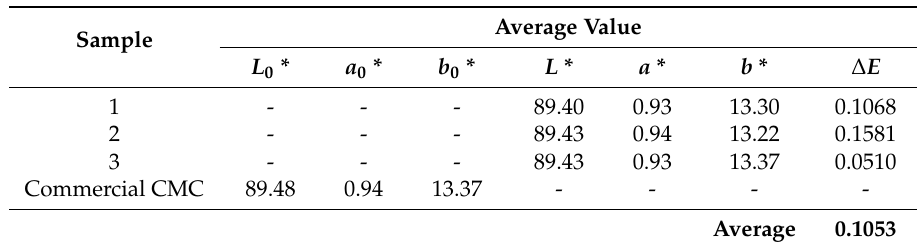
Table 6. Color of CMSC DS